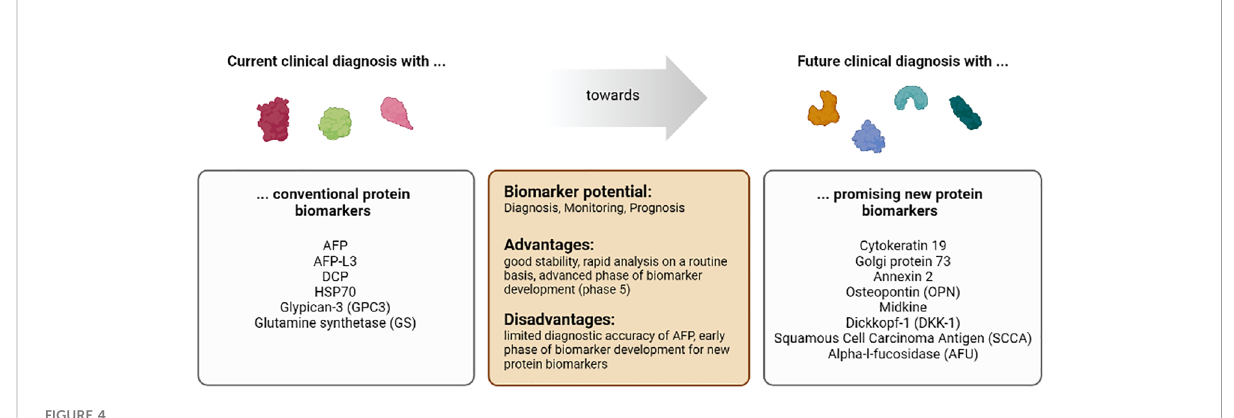
FIGURE 4 Characteristics of the biomarker class proteins in patients with